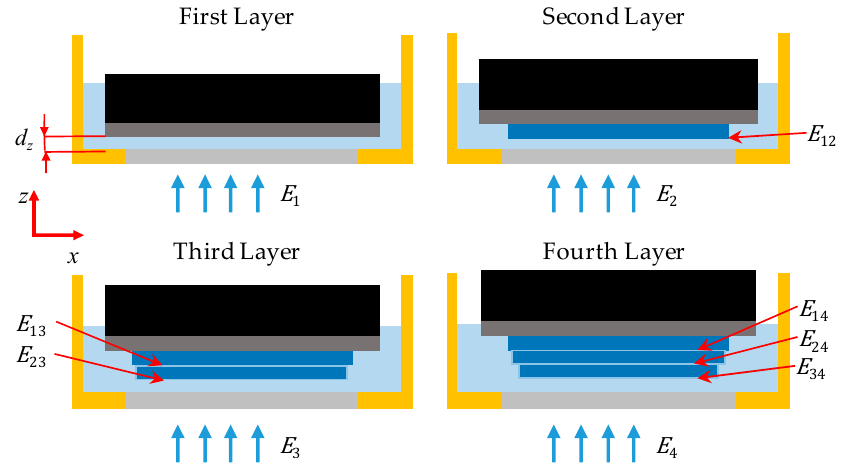
Figure 2. Illustration of the vertical energy accumulation model.